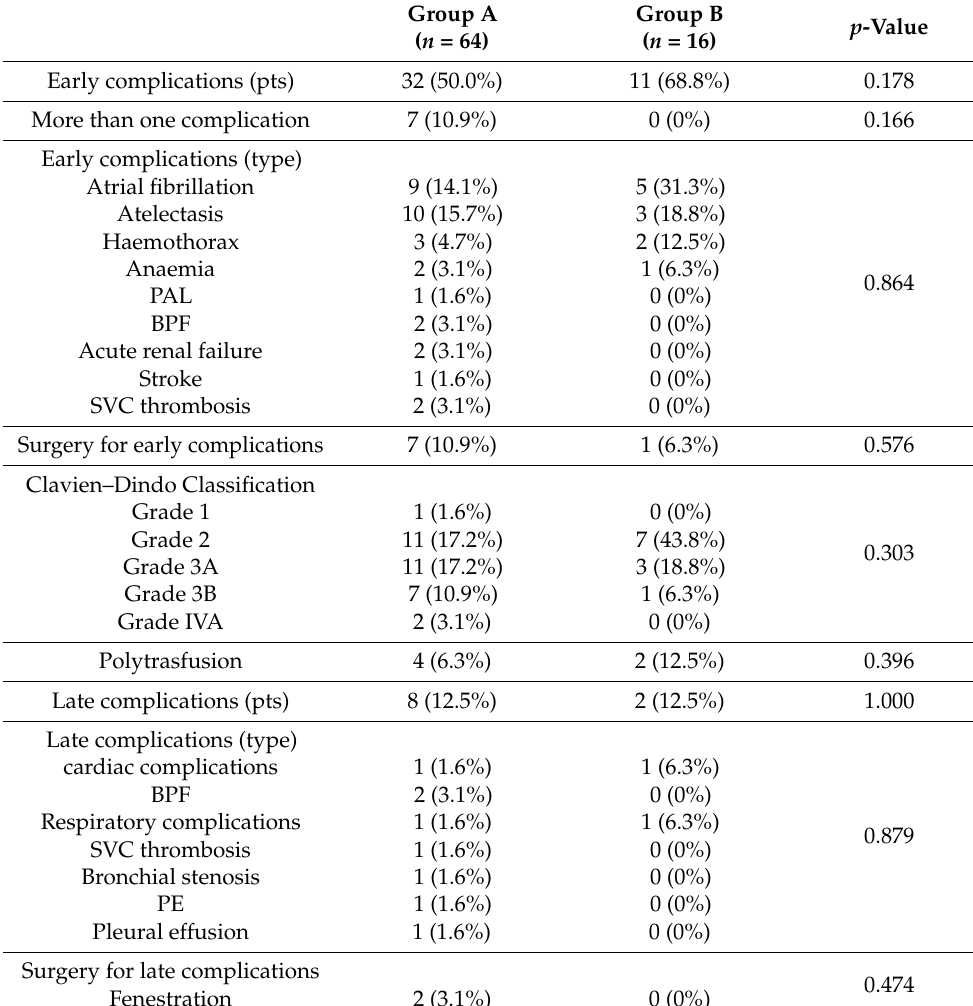
Table 2. Early and long-term